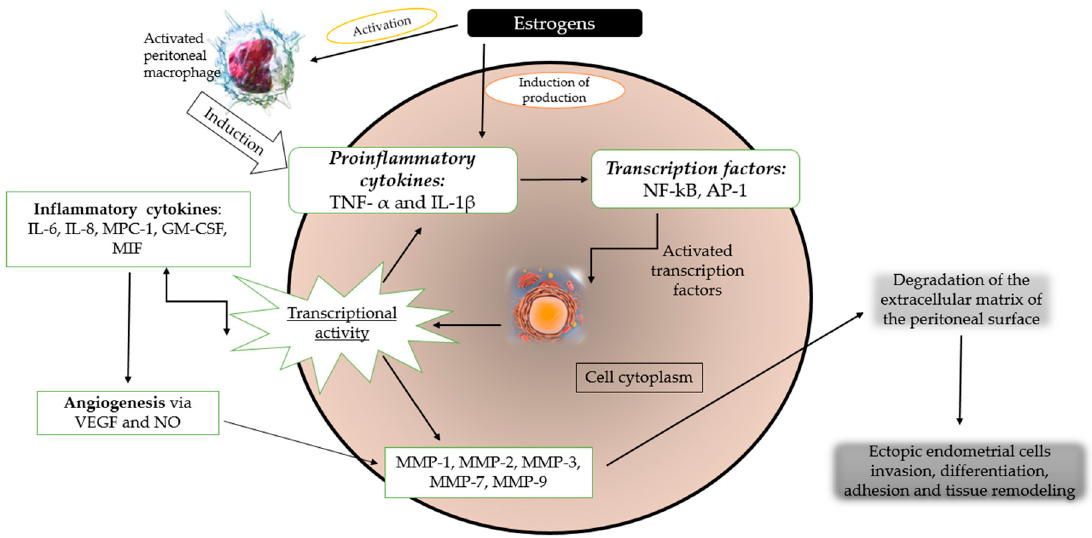
Figure 3. Illustration of molecular pathways in the development of endometriosis [7,68,73–75].